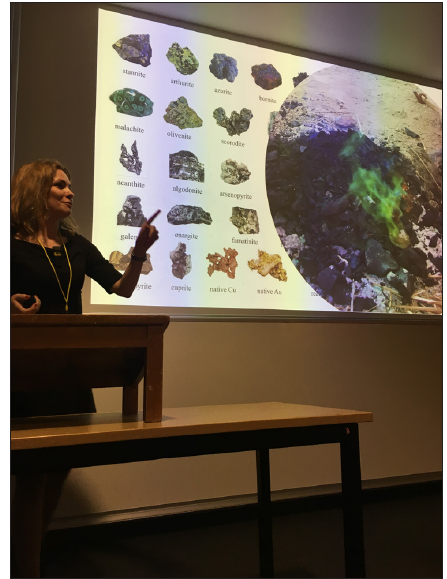
Figure 4: Dr Miljana Radivojevi ć of the Insti- tute of Archaeology delivering her keynote address at the “Trial by Fire” conference (Photo: Lisa